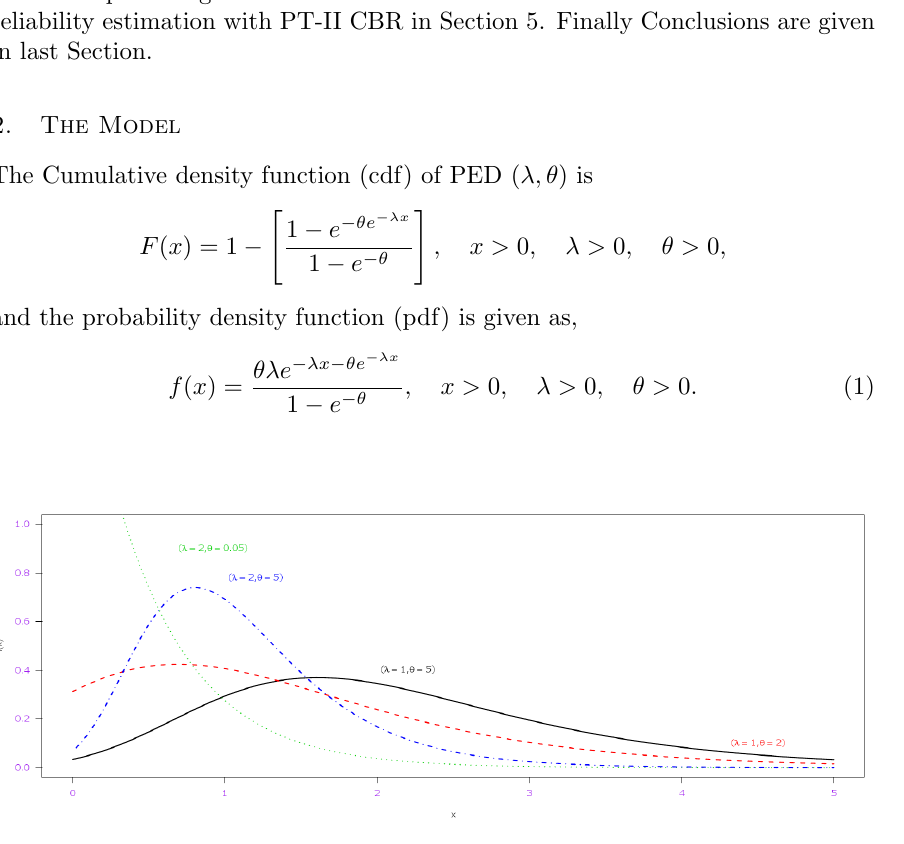
Figure 1 – The pdf plot of PED for different combinations of λ and θ . The parameters (cid:21) and (cid:18) are the scale and shape parameters respectively of the distribution. Figure 1 shows pdfs of PED for different values of (cid:18) and (cid:21) . Its pdf